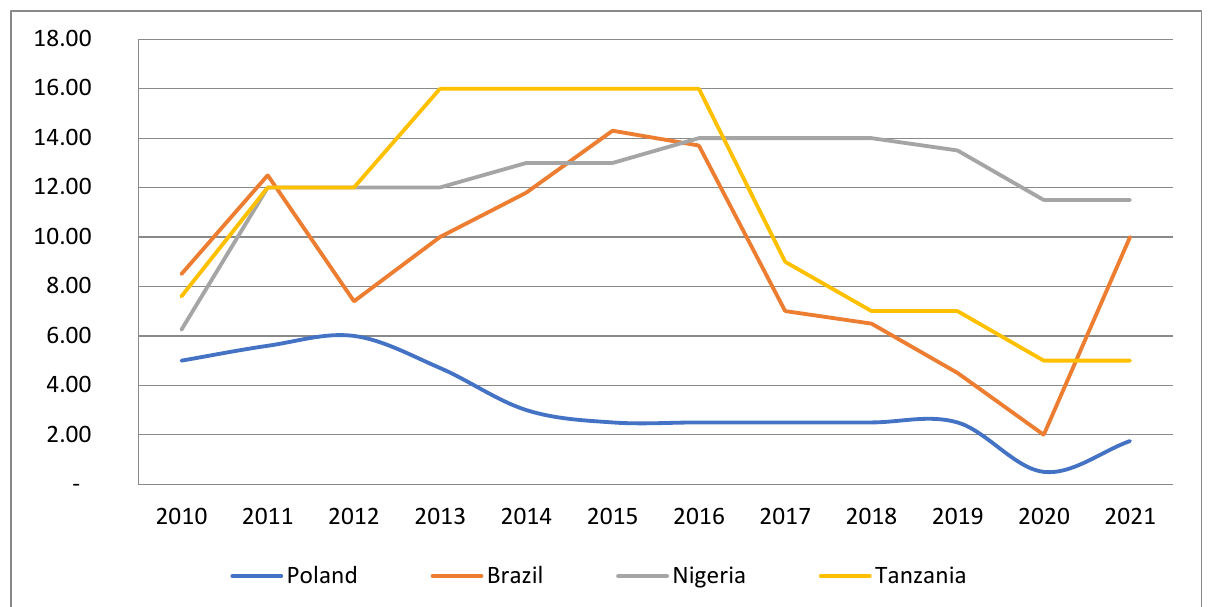
Figure 5. The level of the base rate (%) in the years 2010 – 2021. Source [78 – 85].